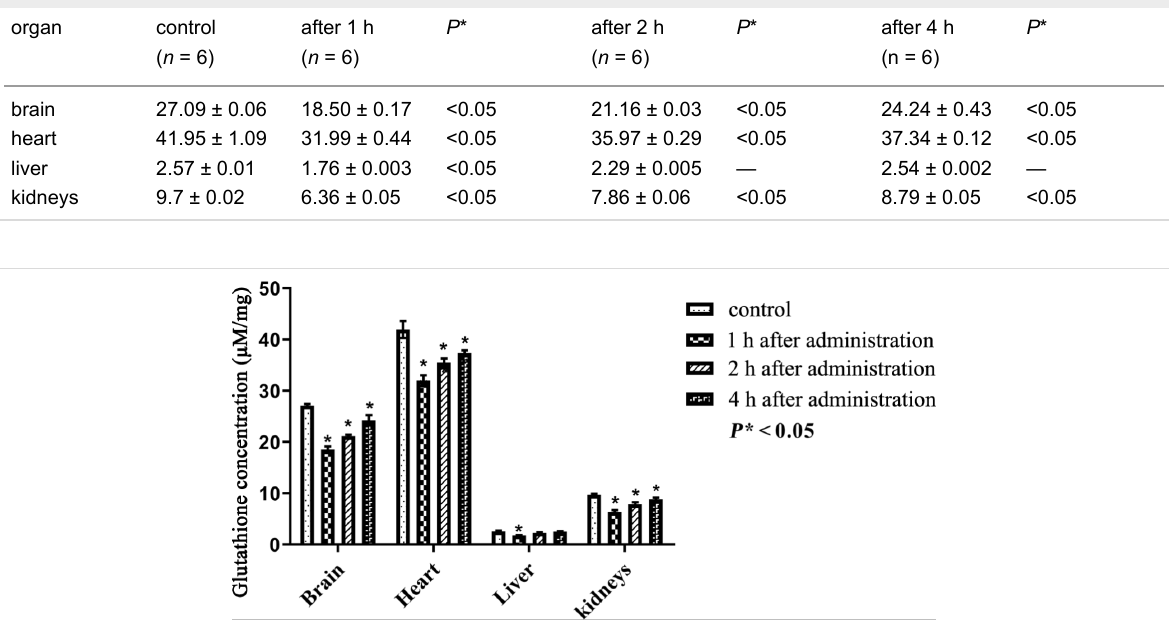
The activity of glutathione S-transferase (GST) plays a central role in preventing damage to tissues. The GST enzyme